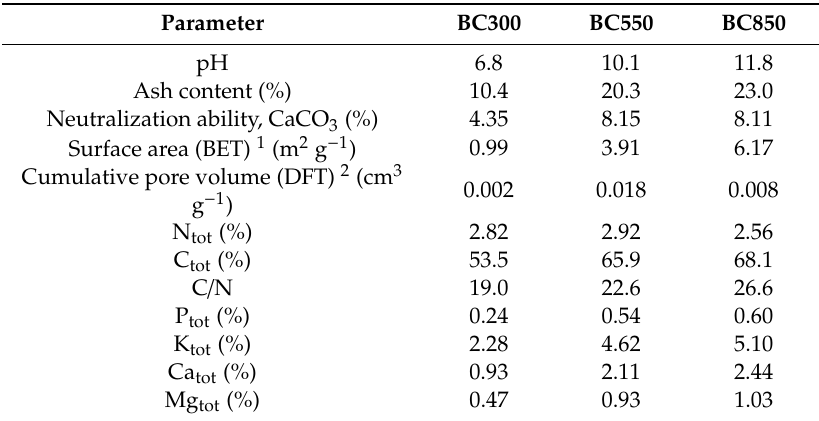
Table 2. Biochar physical and chemical properties. BC300: torrefied granules at 300 ◦ C, BC550: BC300 pyrolyzed at 550 ◦ C, BC850: BC300 pyrolyzed at 850 ◦ C.